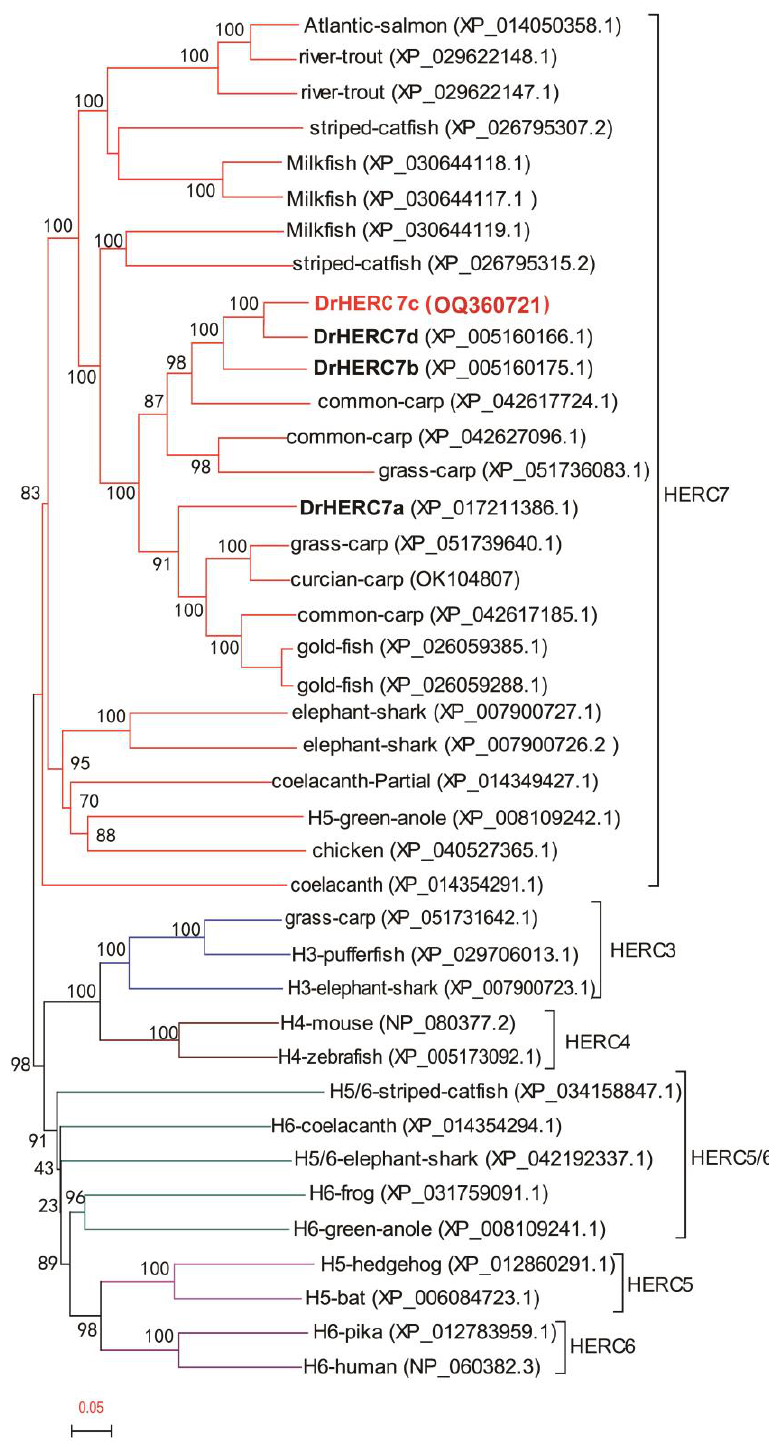
Figure 9. Phylogenetic evolutionary analysis of HERC7 subfamily containing zebrafish